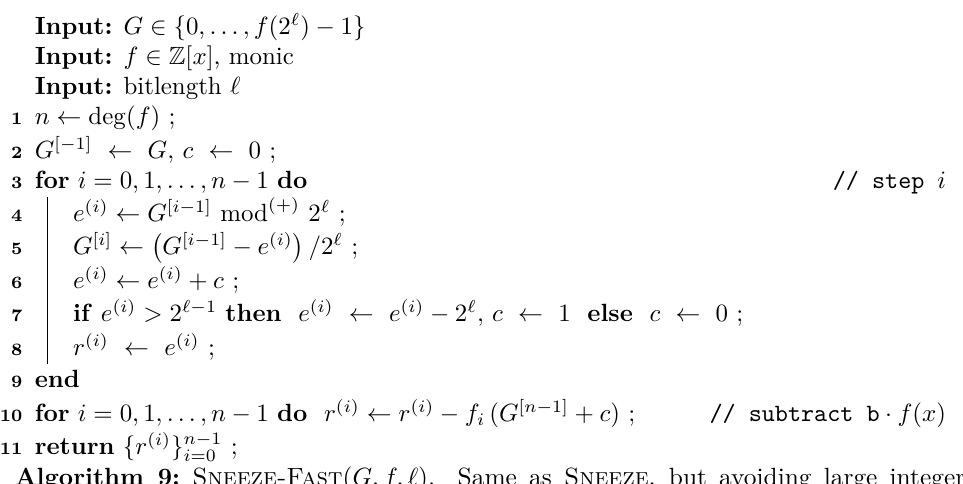
Algorithm 9: Sneeze-Fast ( G, f, ‘ ). Same as Sneeze , but avoiding large integer arithmetic for carry